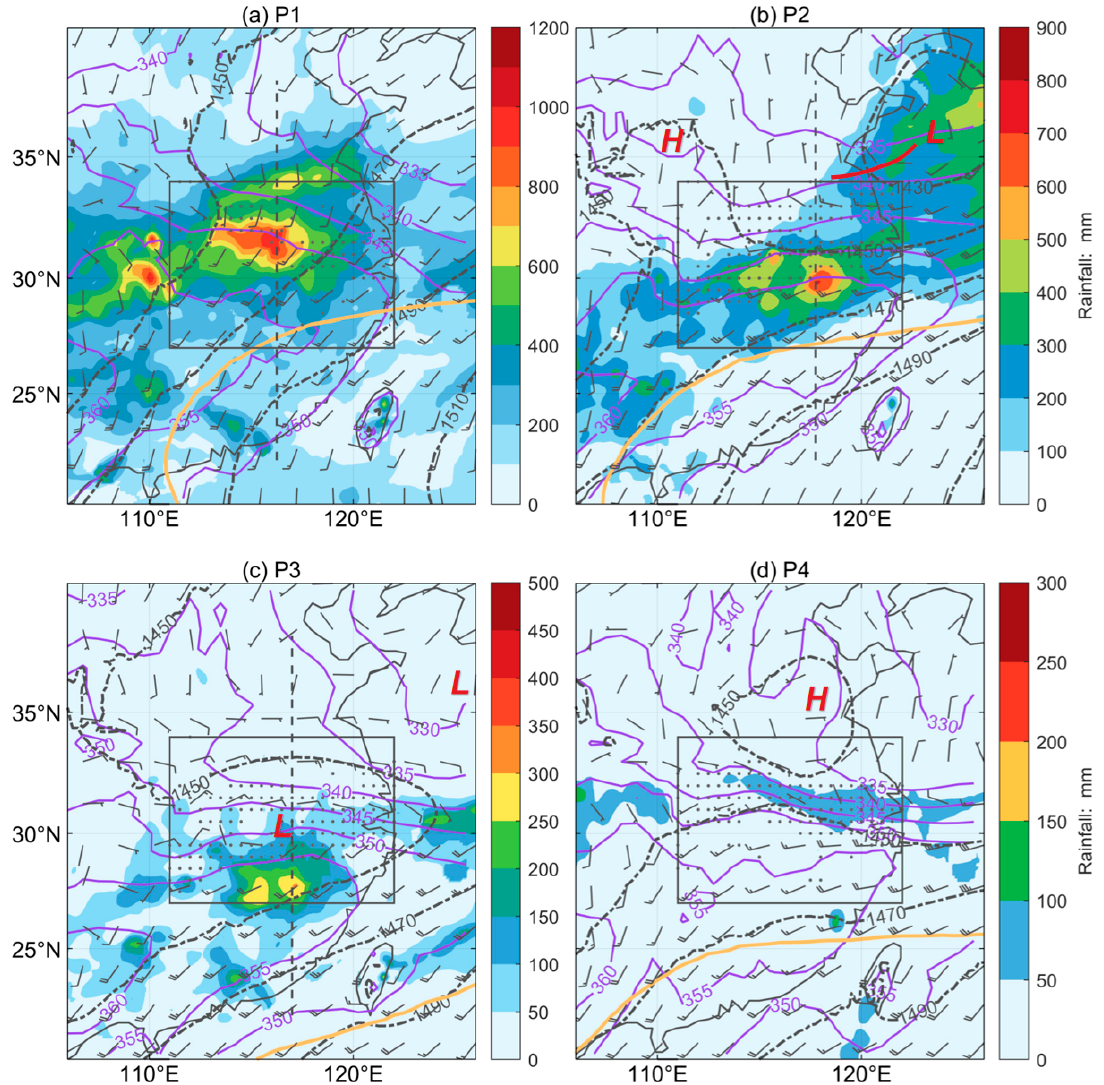
Figure 4. The composite synoptic patterns under the PCT classifications (P1–P4), including the accumulated rainfall (shading, unit: mm) interpolated from the R1m dataset, the mean equivalent potential temperature (purple contours), the mean geopotential height (black dashed contours), and the mean horizontal wind vectors at 850 hPa (a full barb is 4 m s − 1 and a triangle is 20 m s − 1 ). The yellow lines denote the ridge axis of a subtropical high, defined by 5880-gpm at 500 hPa. The black dots denote the area with the maximum gradient of the equivalent potential temperature at 850 hPa greater than 3 K (deg lat − 1 ). The black rectangle represents the study area used for this study, similar to that in Figure 2. The centers of high and low pressures in mid-latitudes are marked by red letters, i.e., H and L . The axis of the trough is denoted by a red solid-line. The black dash lines along